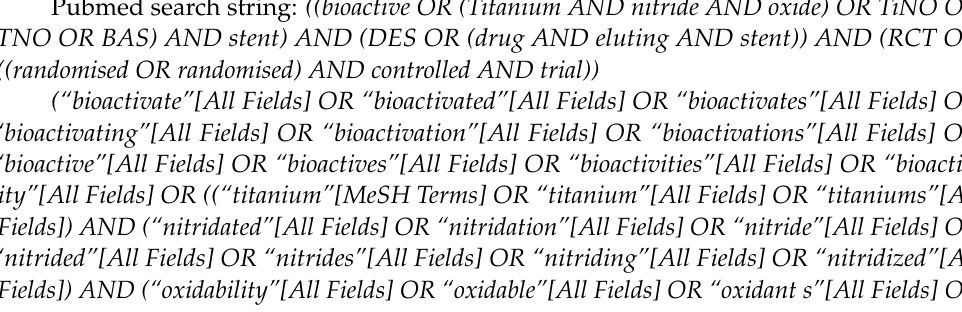
1 year; Figure S2: Recurrent non-fatal MI—5 years; Figure S3: CD—1 year; Figure S4: CD—5 years; Figure S5: Probable or definite ST—1 year; Figure S6: Probable or definite ST—5 years; List of ineligible